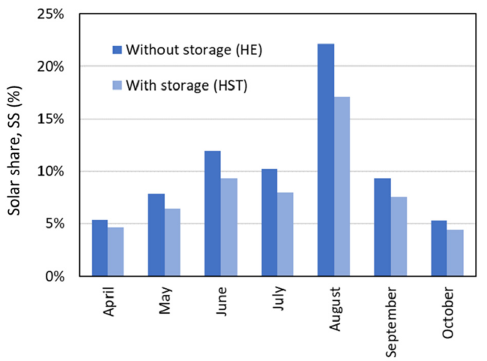
Figure 10. Role of the storage of heat on the monthly averaged solar share for the indirect steam generation assisted by solar thermal